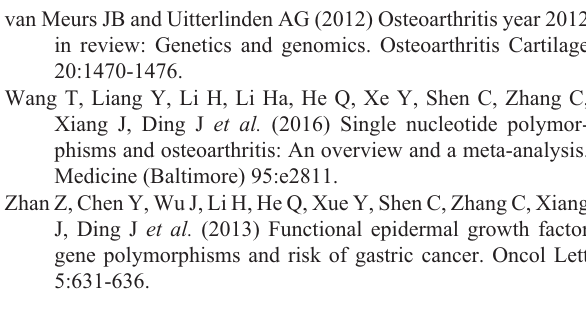
Table S1 - Ancestry informative markers (AIMs) studied. Table S2 - Polymorphisms distribution in groups stratified by gender and age groups. Table S3 - Polymorphism interactions by logistic